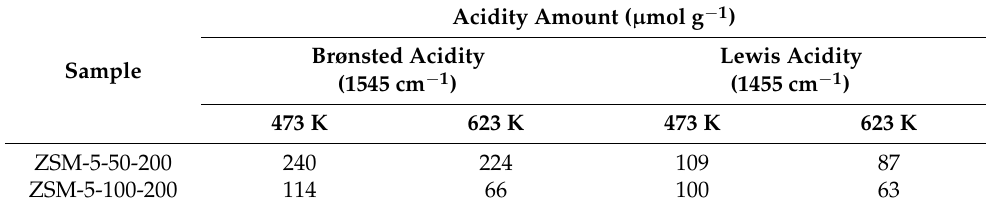
lows: In the process of synthesis, zeolitic precursors dissolve in the aqueous medium, in which nucleation takes place. The toluene phase disperses the aqueous phase into a dis ‐